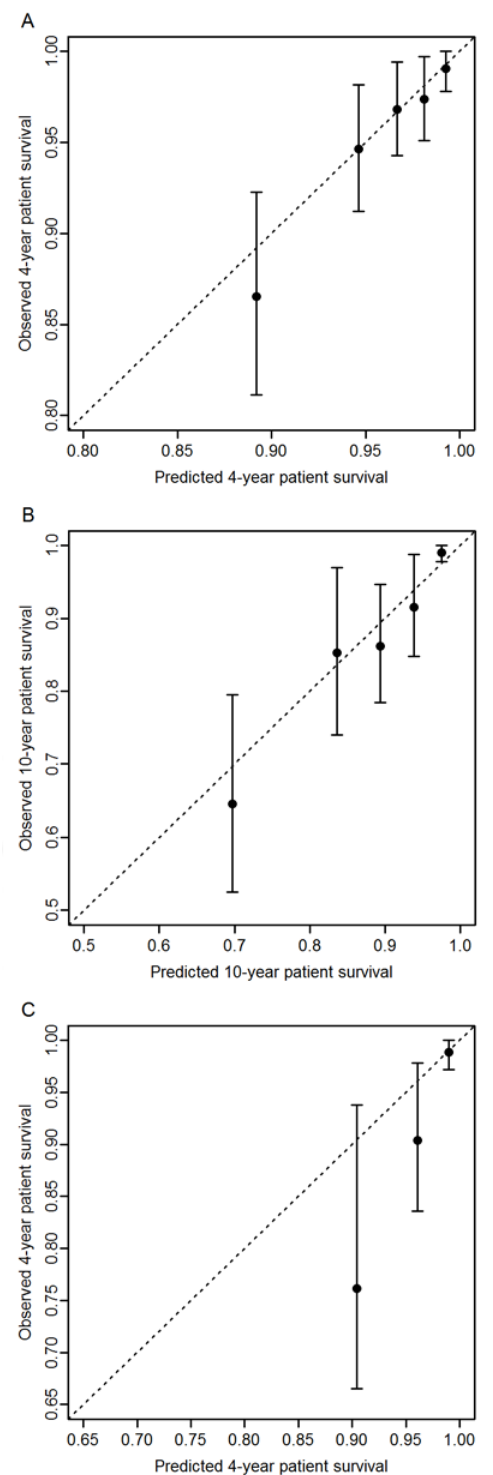
Fig 4. Calibration curves of the observed patient survival according to the predicted patient survival based on the 1-year RRS. (A) Patient survival was estimated from the DIVAT internal validation sample (n = 1148) at 4 years since the first anniversary of the transplantation. The sample was divided into 5 risk groups defined by the predicted patient survival. (B) Patient survival was estimated from the DIVAT internal validation sample (n = 1148) at 10 years since the first anniversary of the transplantation. The sample was